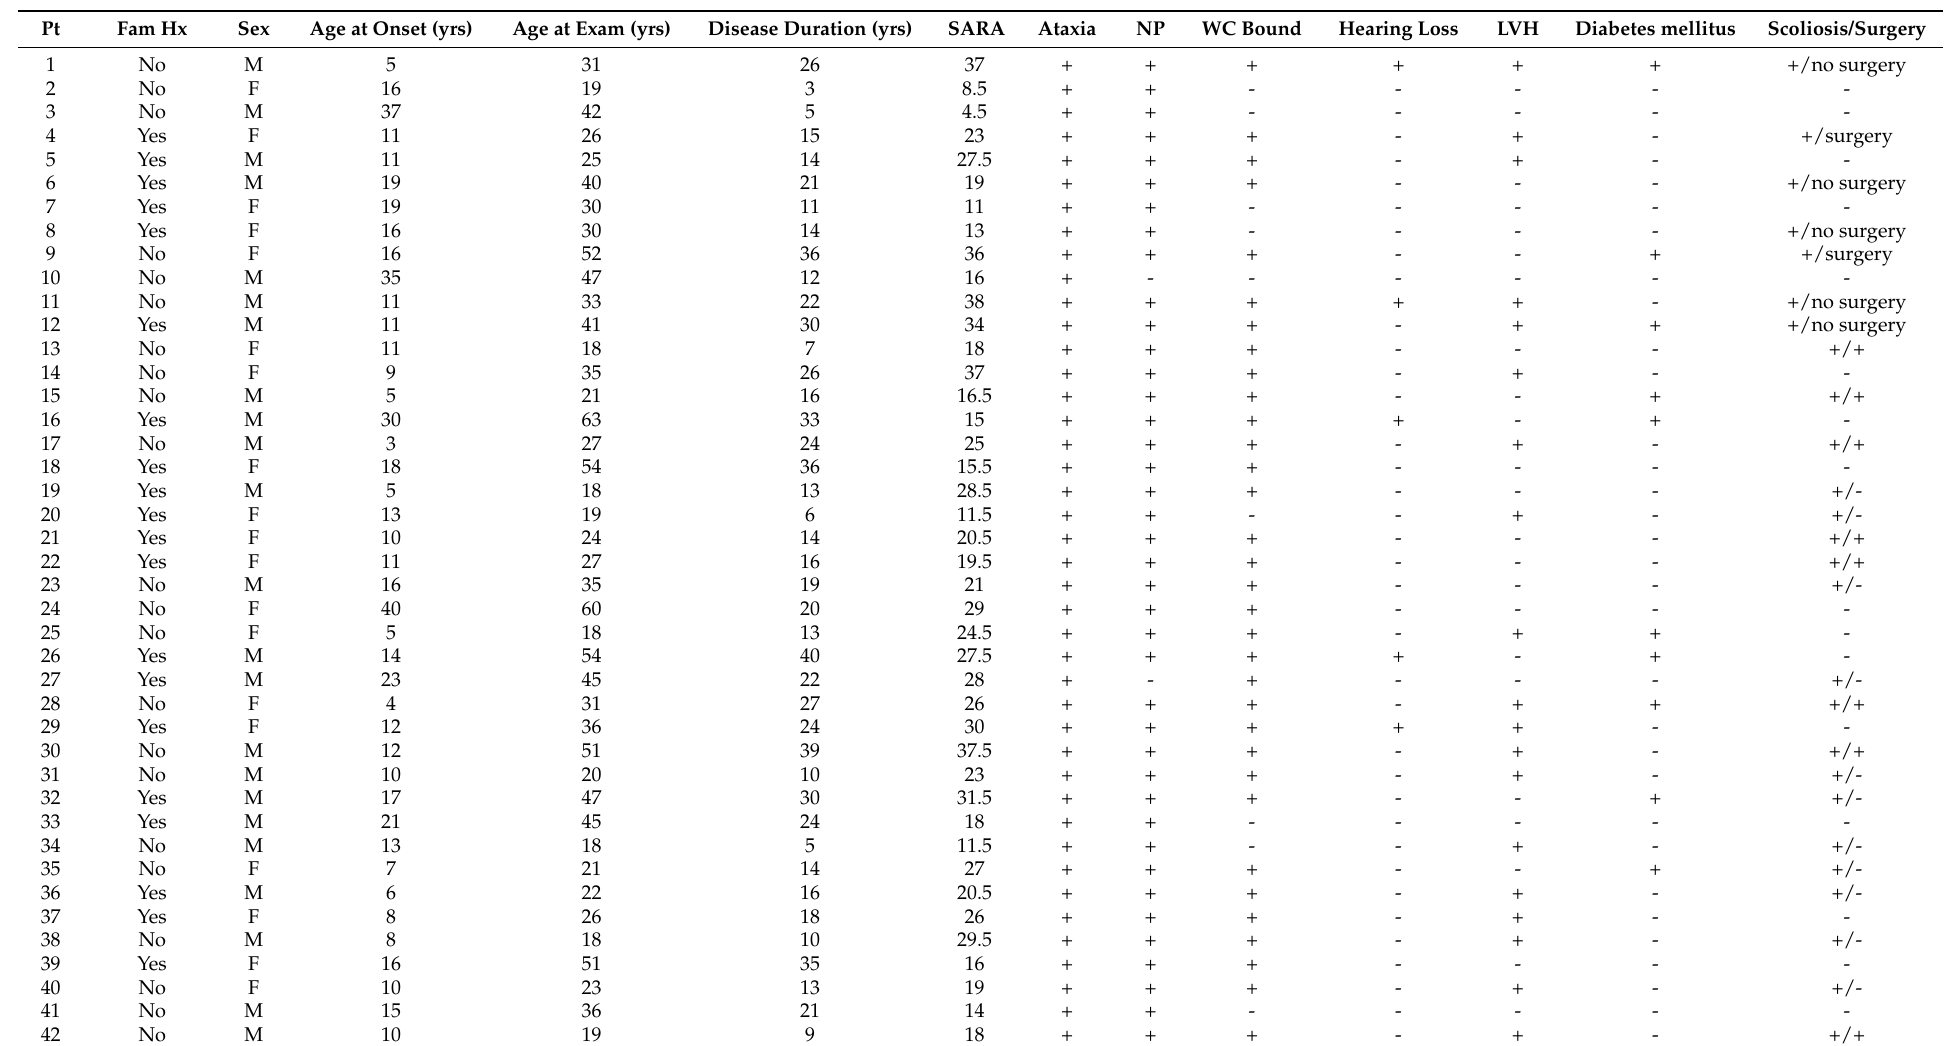
Table 1. Demographic and clinical characteristics of individuals with